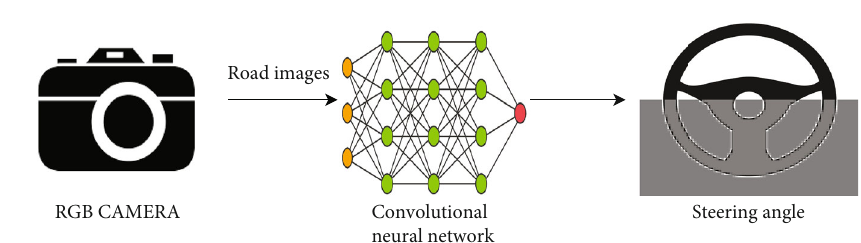
Figure 2: End-to-end learning for